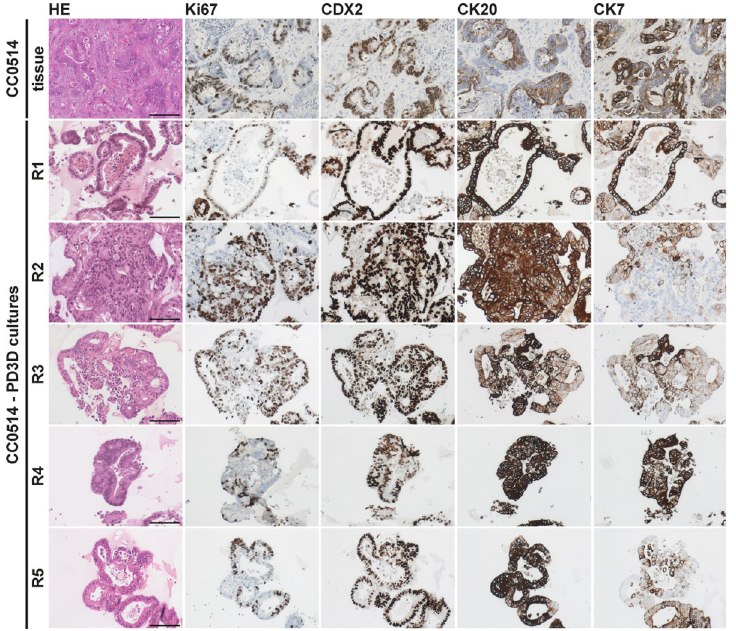
Fig 4. Immunohistochemical stainings of “sibling organoids” and original colorectal carcinoma. Immunohisto- chemical staining with hematoxylin and eosin (HE) and expression of Ki67, CDX2, CK20 and CK7 show overlapping patterns in tumor tissue and derived PD3D cultures R1-R5 of patient CC0514. Scale bars: 200 μ